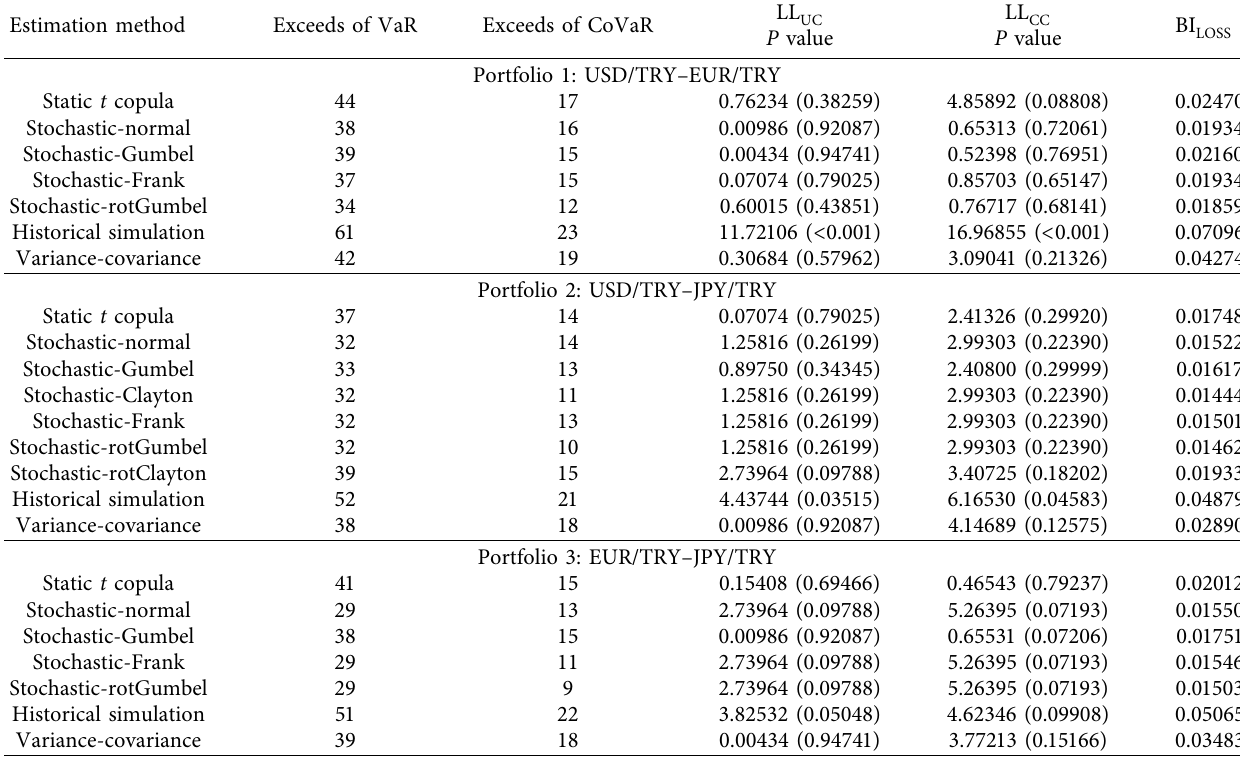
Table 4: Backtesting of VaR forecasts at 95% confidence level.